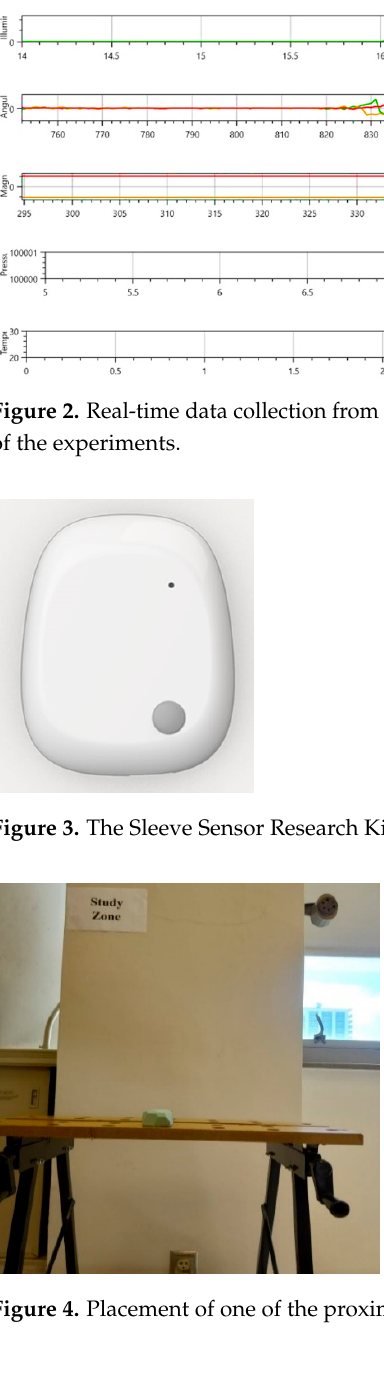
Figure 5. Placement of multiple proximity sensors in the ‘study-zone’.